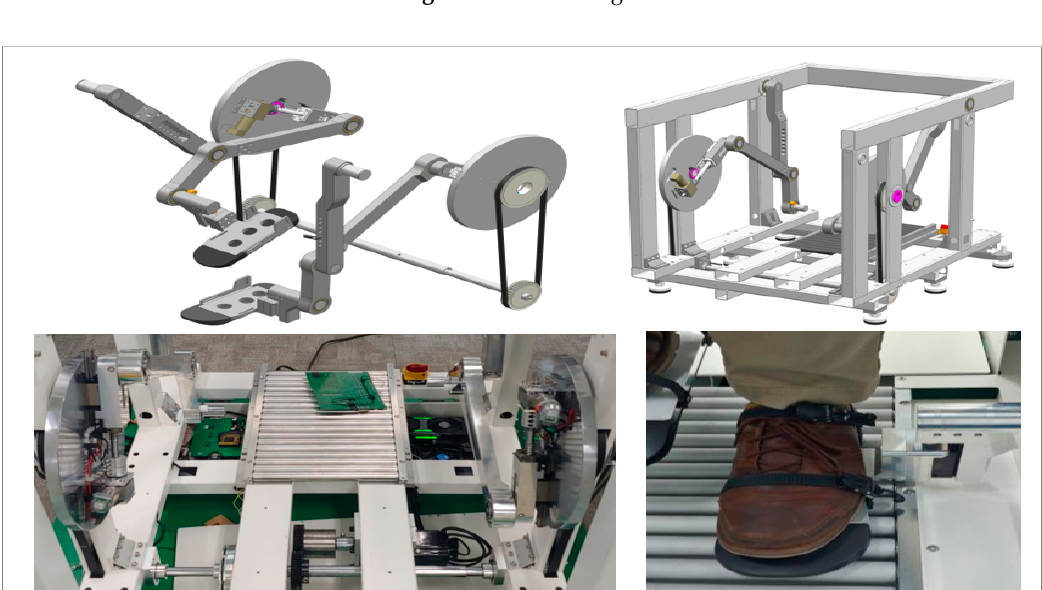
Figure 2. Mechanism of gait functionality.